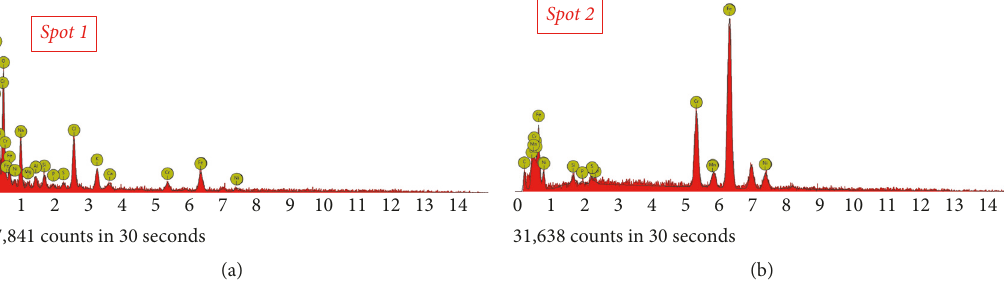
Figure 6: Spectrogram (SEM-EDS) obtained due to chemical analysis conducted in spots marked in Figure 5: (a) a corrosive sediment and (b) surface of base